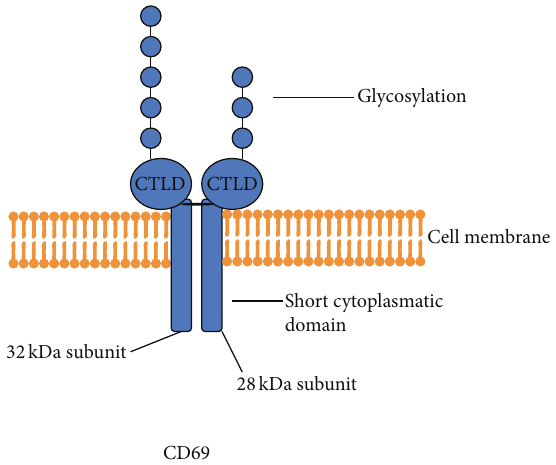
Figure 1: The structure of CD69 molecule. CD69 is membrane- bound protein, a homodimer of two (28 and 32 kDa) differentially glycosylated subunits. Each subunit consists of extracellular C-type lectin domain (CTLD) connected by the short neck region with the single spanning transmembrane domain and short cytoplasmatic tail. Subunits are connected with the disulfide bridge in the extra- cellular neck